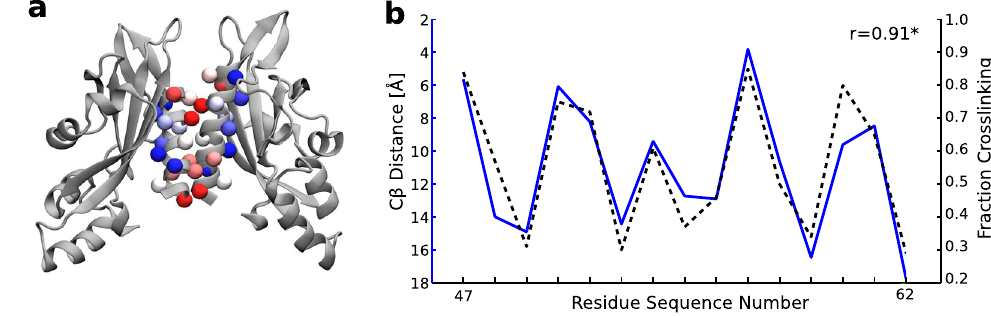
Figure 4. Assembly of a periplasmic sensor. ( a ) Best model of the PhoQ periplasmic sensor obtained by mViE. The colors of residue C β atoms represent the degree of crosslinking from highly (red) to poorly (blue) crosslinked. ( b ) Fraction crosslinking vs. C β distance for the best structural model of the PhoQ periplasmic